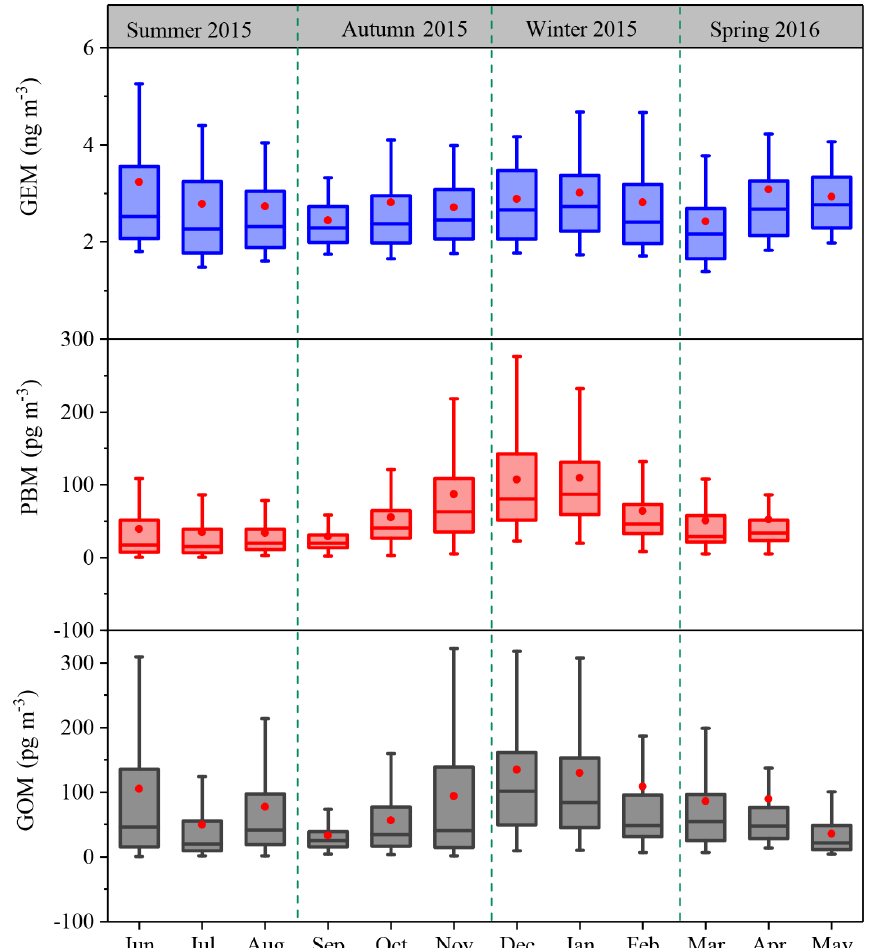
Figure 3. Monthly variation in GEM, PBM, and GOM concentrations. The 10th, 25th, median, 75th, and 90th percentile values are indicated in the box plots. The red dots represent the mean values.